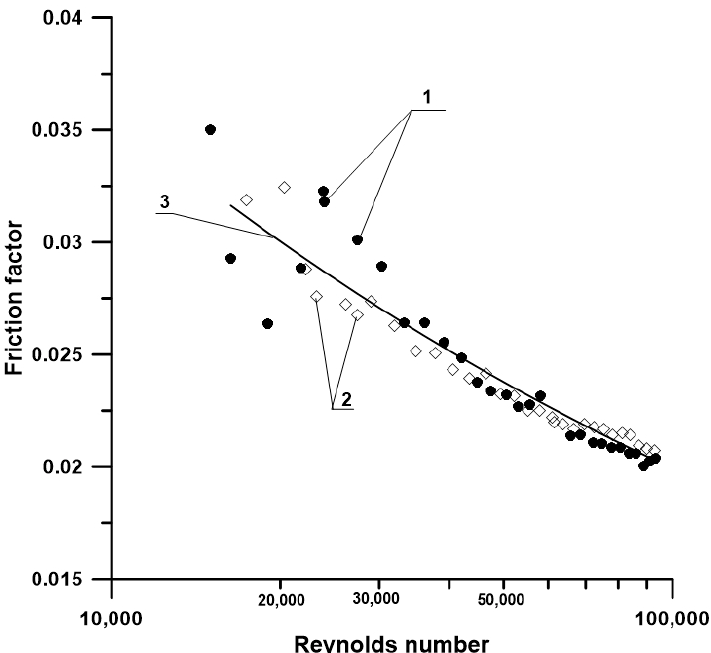
Figure 9. Comparison of the friction factor values obtained by means of a PXWD transducer and a U-tube in relation to the equation values; 1—PXWD transducer; 2—U-tube; 3—Equation